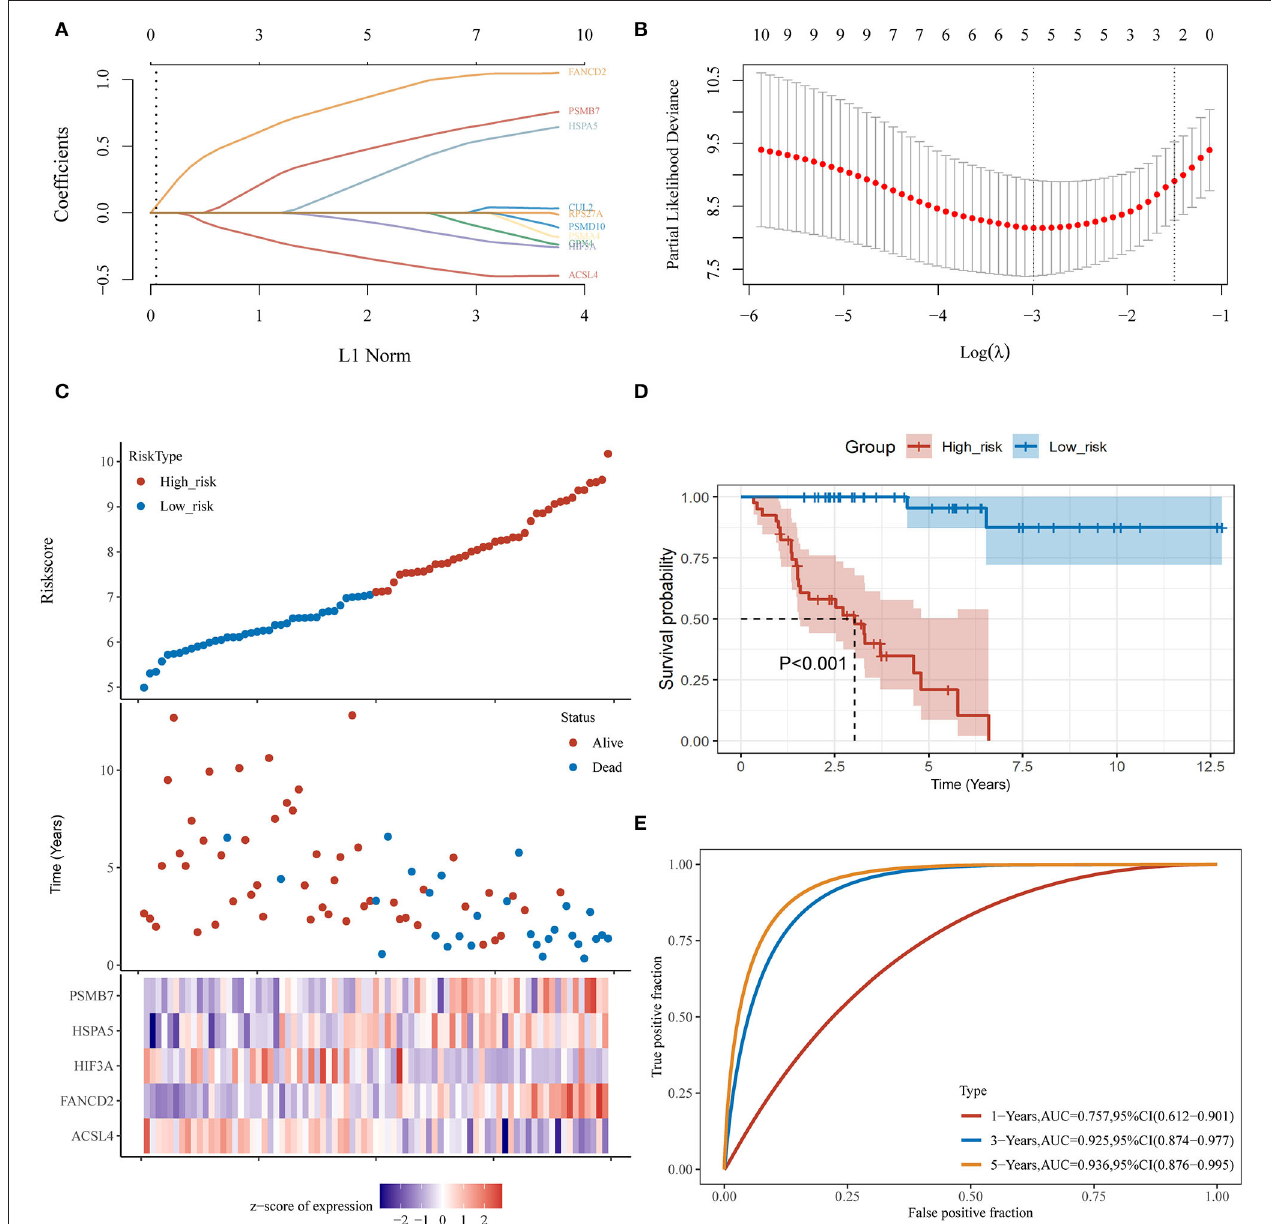
FIGURE 5 | Establishment of a hypoxia- and ferroptosis-related predictive model. (A) LASSO coefficient profiles of 12 hypoxia-related and ferroptosis-related genes; (B) LASSO regression with 10-fold cross-verification; (C) Heatmap of the expression profiles of 5 prognostic genes in low-risk and high-risk group; (D) Kaplan-Meier survival analysis of the gene signature; (E) Time-dependent ROC analysis of the gene signature. ACC, adrenocortical carcinoma; LASSO, least absolute shrinkage and selection operation; ROC, receiver operating characteristic